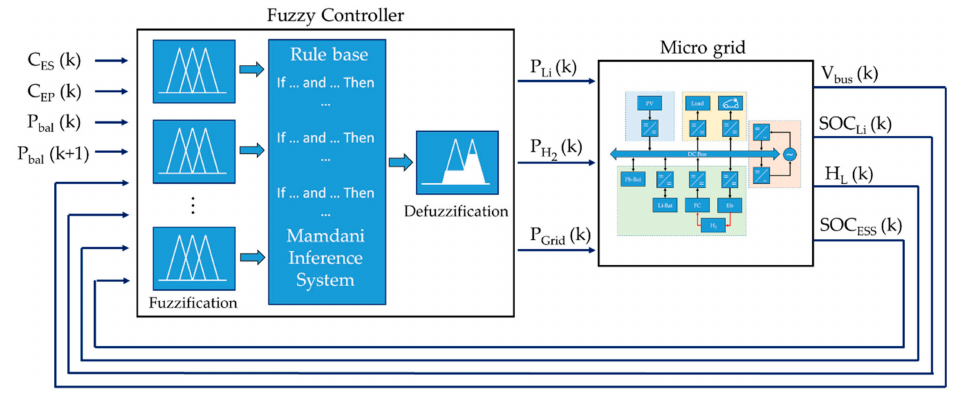
Figure 5. EMS control